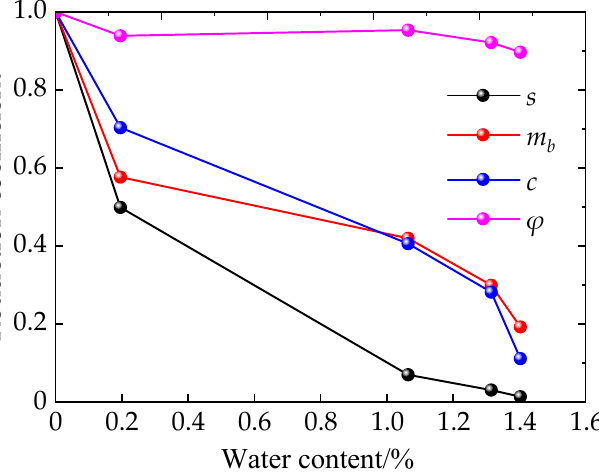
Figure 10. Plot of the reduction coefficient between the water content and the peak constitutive parameters.